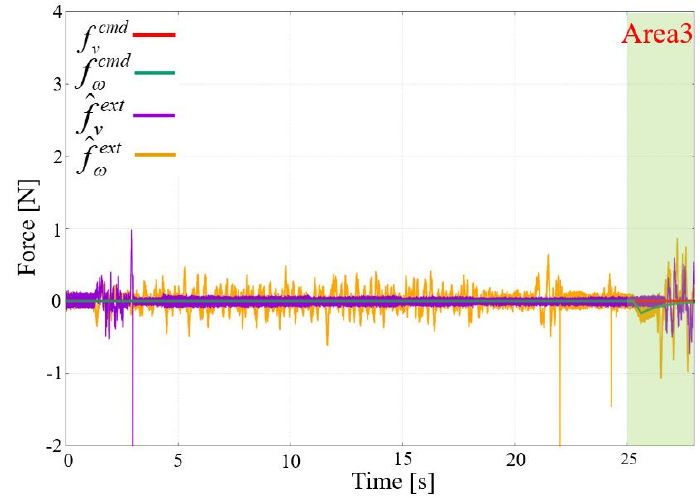
Figure 20. Experimental results of force commands of Case 4 for Subject A.